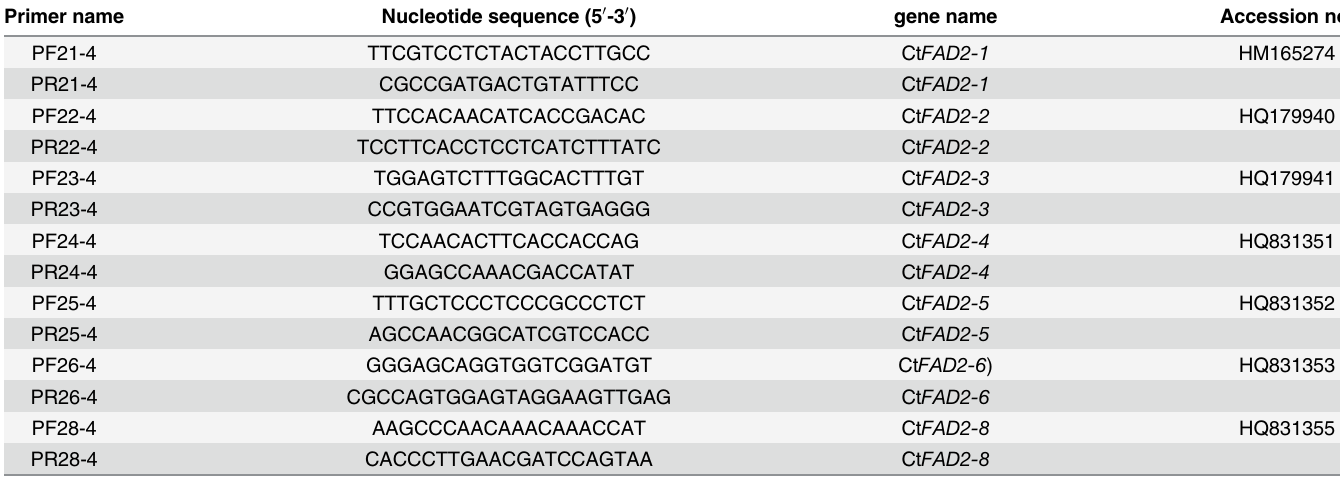
Table 4. The primer information of CtFAD2 genes used in this study for validating the most stable RGs.